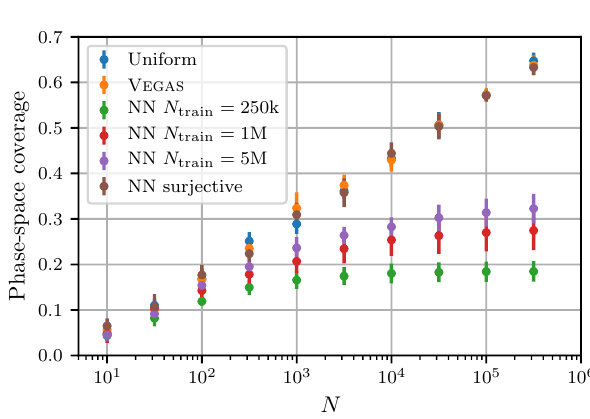
(a) The phase space coverage for different sampling methods as a function of the number of unweighted events N . The error bars indicate the spread over 10 statistically independent samples. For the NN, also the training has been independently repeated, each time with a new set of randomly initialised weights. For the non-surjective NN setup, the effect of using different number of training points N is illustrated.